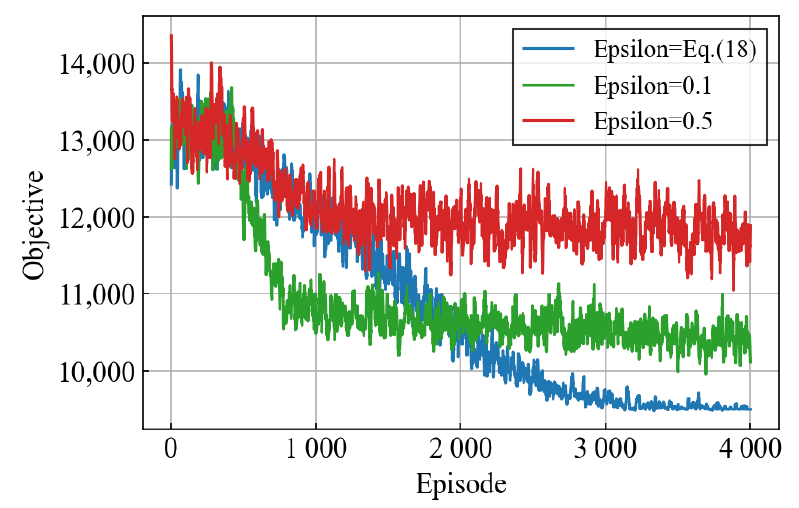
Figure 8. The learning curve obtained with QL considering different exploration rates in the test